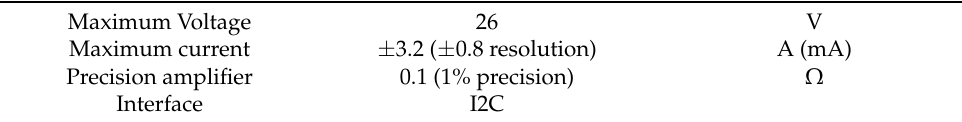
Table 4. Hall effect DC current sensor data.